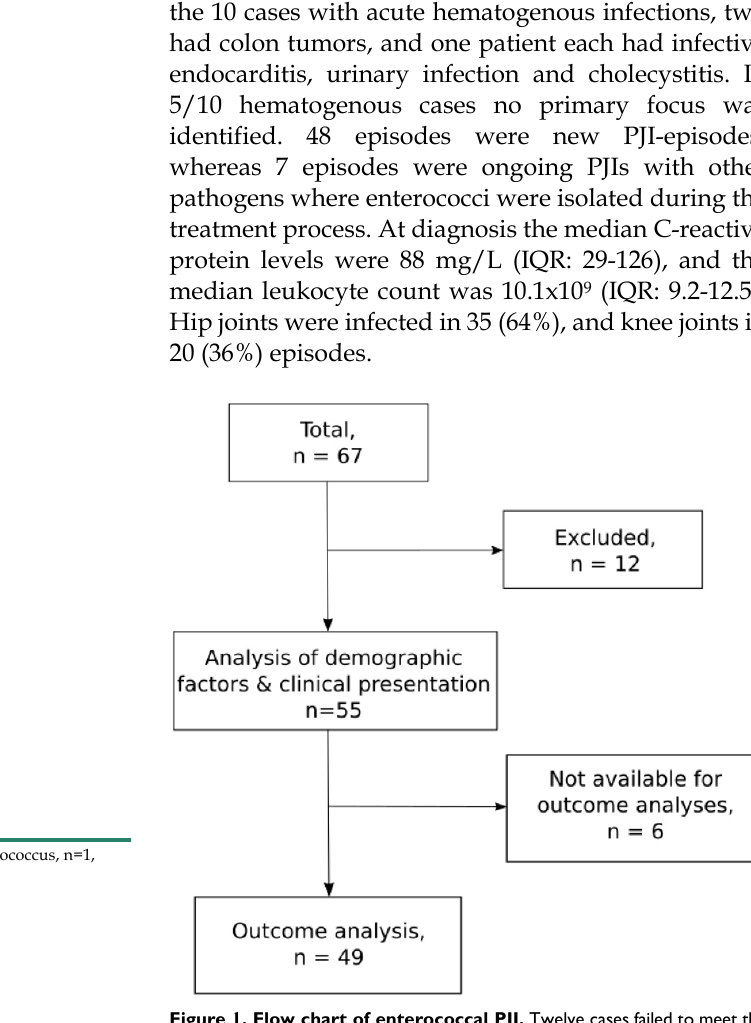
Figure 1. Flow chart of enterococcal PJI. Twelve cases failed to meet the inclusion criteria due to non-significant growth (n=6), partial treatment outside Skåne (n=2), episode start before study-period (n=2) and not being prosthesis-related (n=2). Six cases were excluded from the outcome analyses due to death within a year from other causes (n=2) and follow up < one year